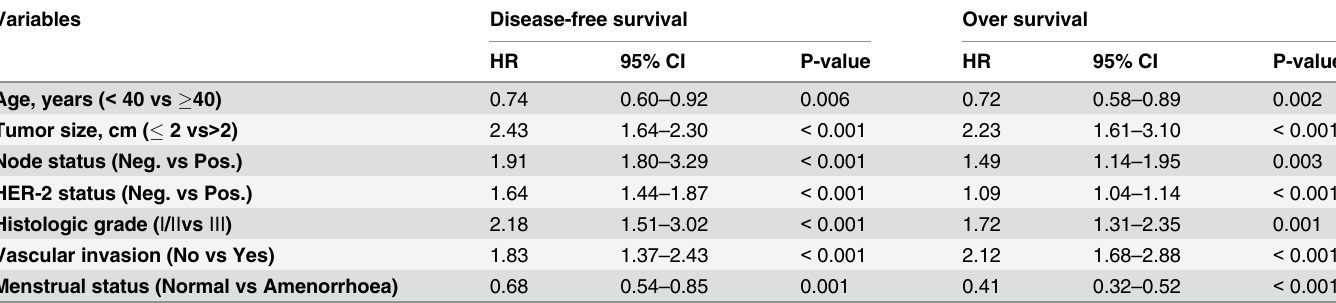
Table 2. Multivariate analysis of disease-free survival and overall survival in all